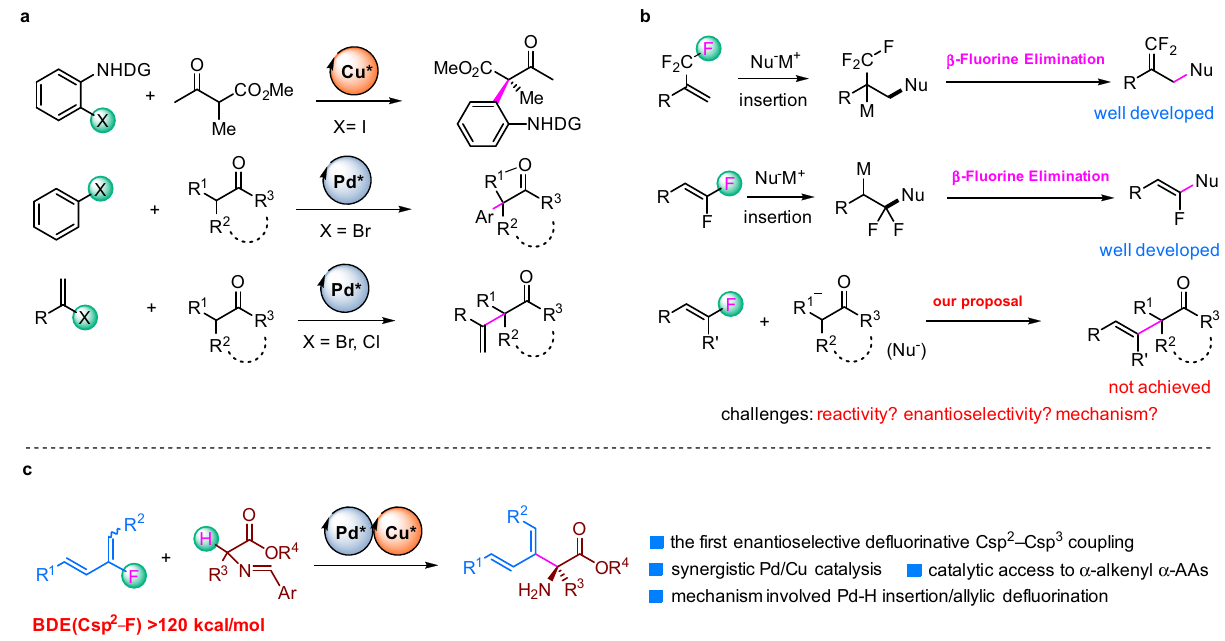
Fig. 1 Transition-metal-catalyzed asymmetric Csp 2 – Csp 3 cross-coupling reactions. a Enantioselective Csp 2 – Csp 3 cross-coupling of Csp 2 – I (Br, Cl) Bonds. b C – F bond Activation by Nu-M Insertion/ β - fl uorine elimination. c This work: C – F bond activation by Pd-H insertion/allylic de fl uorination for Csp 2 – Csp 3 cross-coupling.